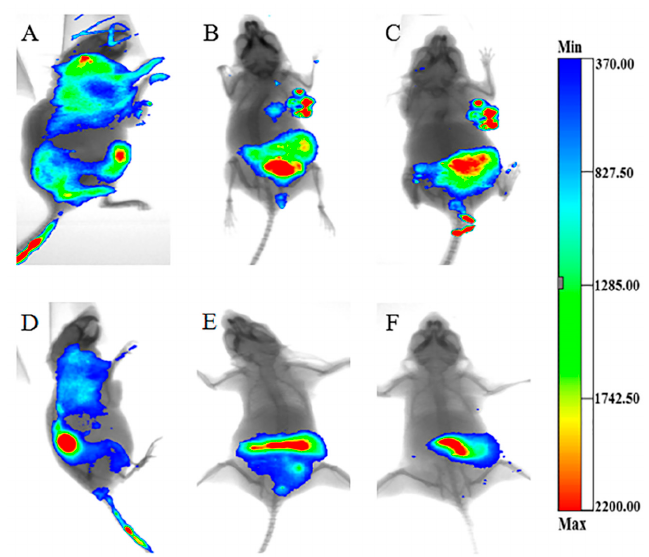
Figure 16. Fluorescent images of nude mice treated with GRcR/Cy5- VEGF-siRNA . ( A ) GRcR/Cy5- VEGF-siRNA at 30 min. ( B ) GRcR/Cy5- VEGF-siRNA at 5 h. ( C ) GRcR/Cy5- VEGF-siRNA at 8 h. ( D ) Cy5- VEGF-siRNA at 30 min. ( E ) Cy5- VEGF-siRNA at 5 h. ( F ) Cy5- VEGF-siRNA at 8 h.